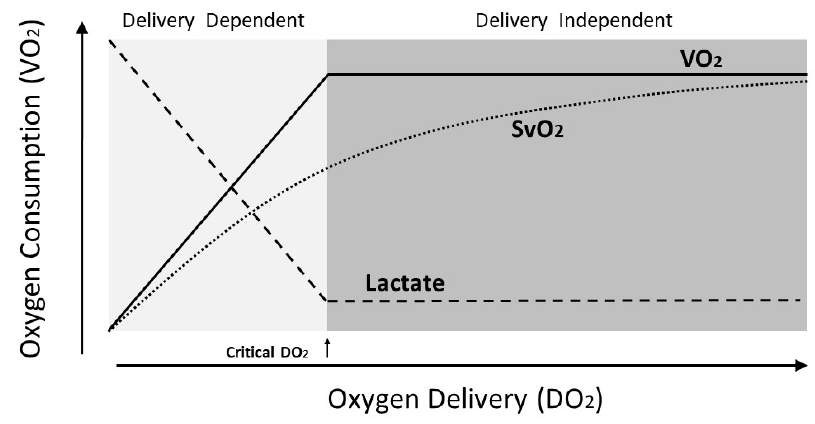
Figure 5. Relationship of oxygen delivery (DO 2 ), oxygen consumption (VO 2 ), venous oxygen saturation (SvO 2 ), and lactate. Below the critical DO 2 threshold, SvO 2 decreases and lactate increases, reflecting ongoing oxygen deficit and accumulating oxygen debt.